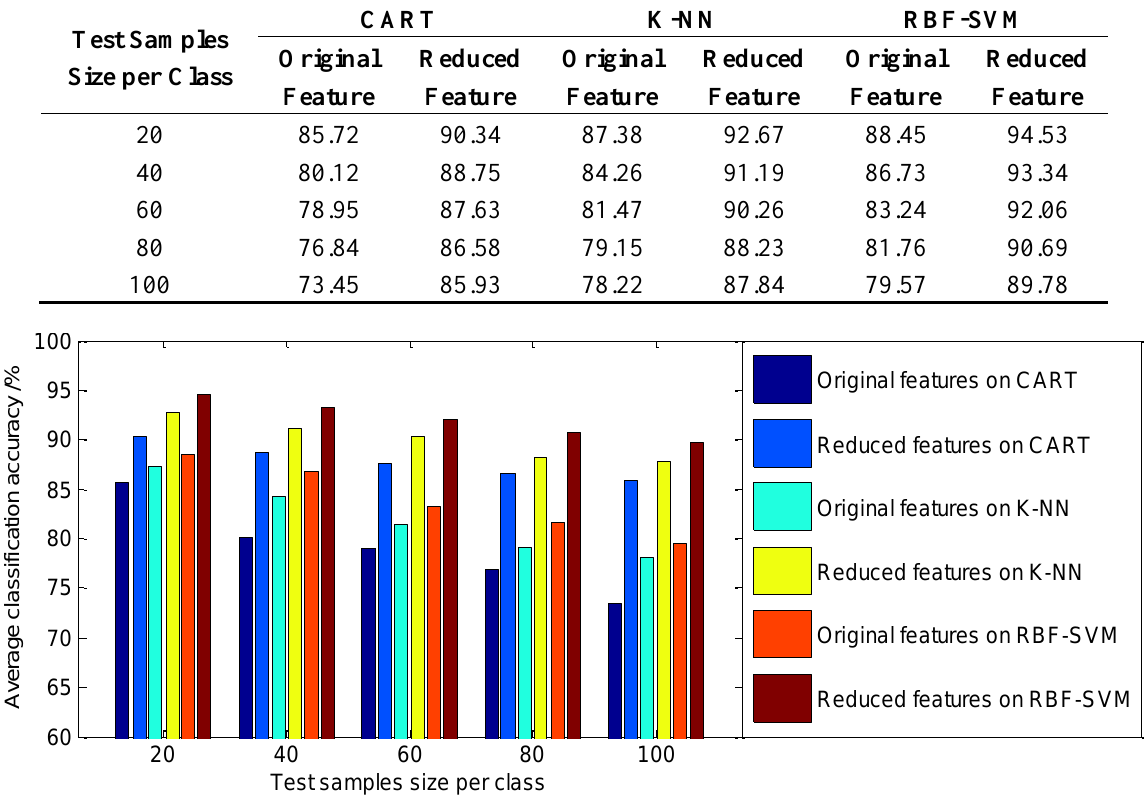
Table 4. The average classification accuracy (%) the original and reduction of statistical features extracted from multi-domain by various classifiers using supervised LLE.